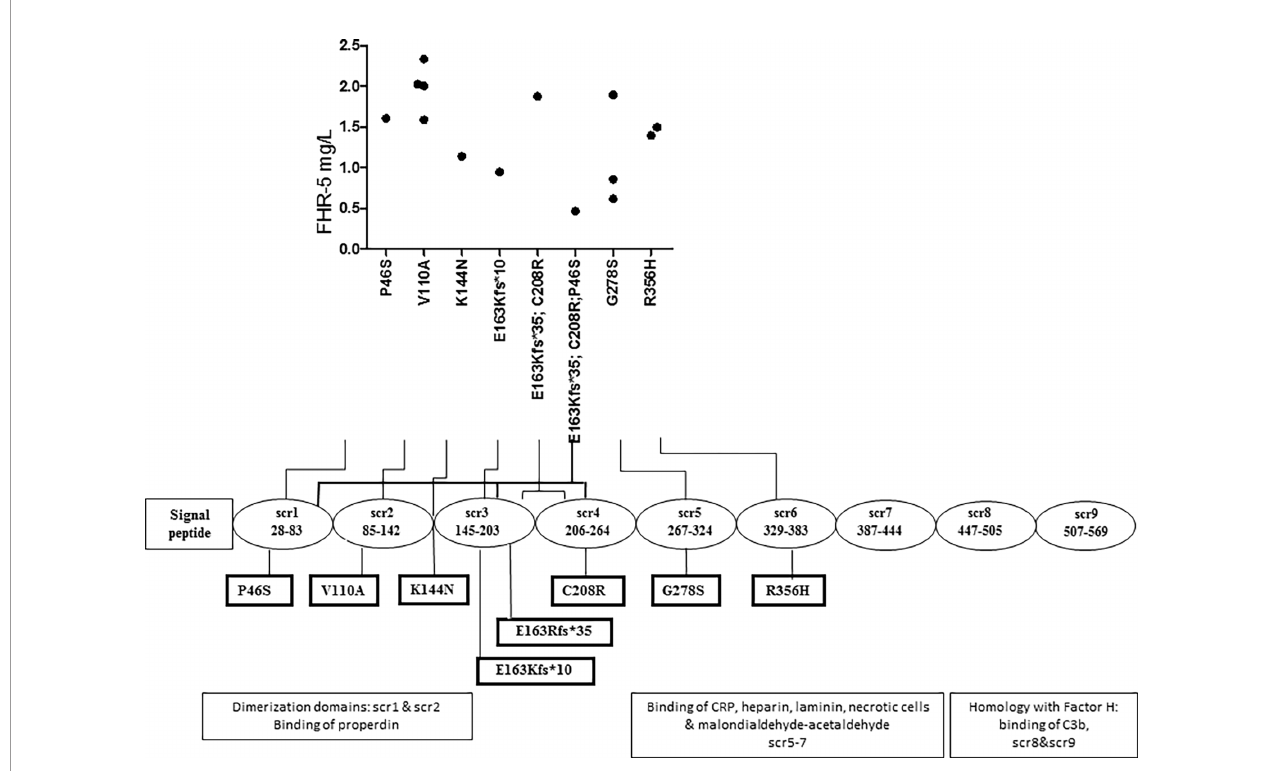
FIGURE 3 | Localization of missense and frame-shift CFHR5 variations and the serum level of Factor H-related protein 5